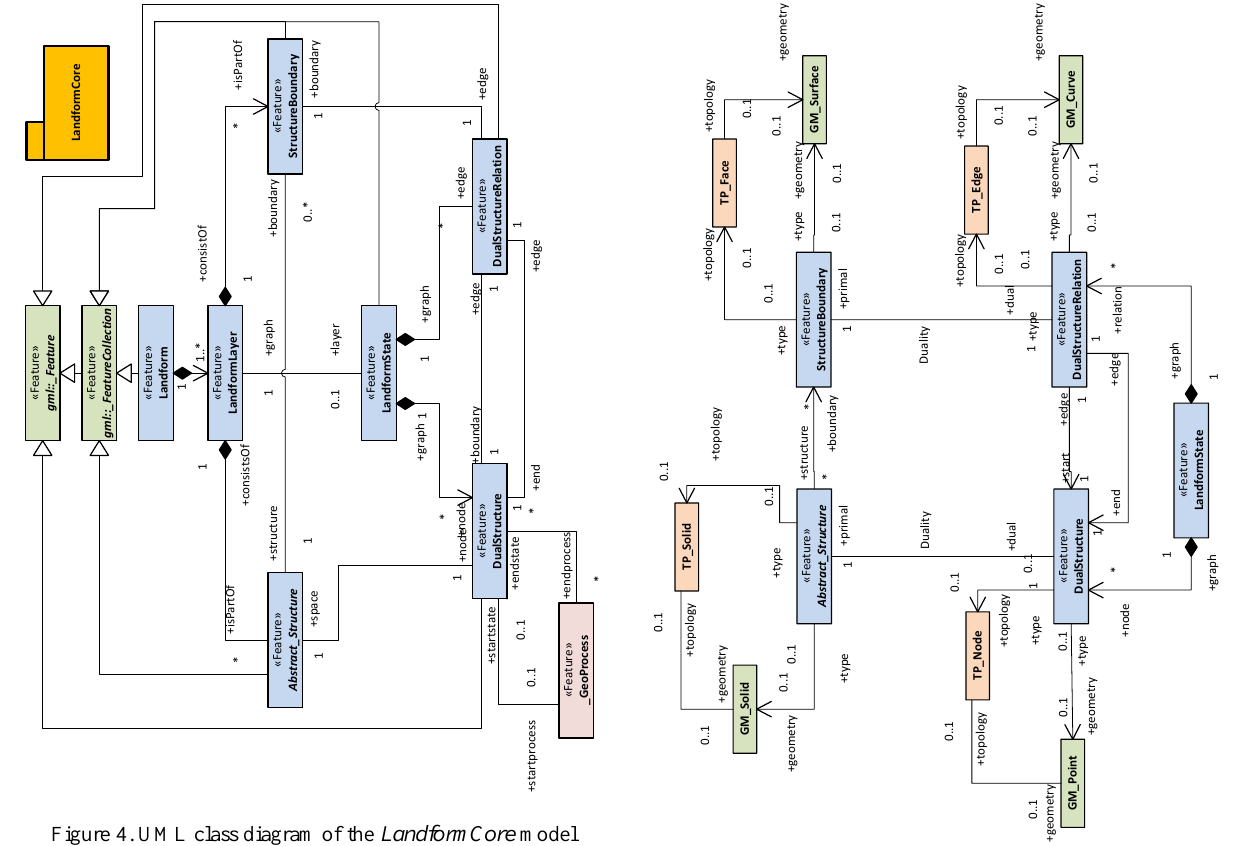
Figure 4. UML class diagram of the LandformCore model Solid 3D objects in primal space, e.g., horizons of a landform, are mapped to nodes (0D) in dual space. The common 2D face ( StructureBoundary ) shared by two solid objects is transformed into an edge (1D) linking two nodes in dual space. Thus, edges of the dual graph represent adjacency relationships in primal space. A formal definition of the Poincaré Duality is given by Munkres (1984). Thus, each LandformState represents a subgraph of the whole landform graph structure on the one hand side and on the other hand side a period in time of landform genesis.